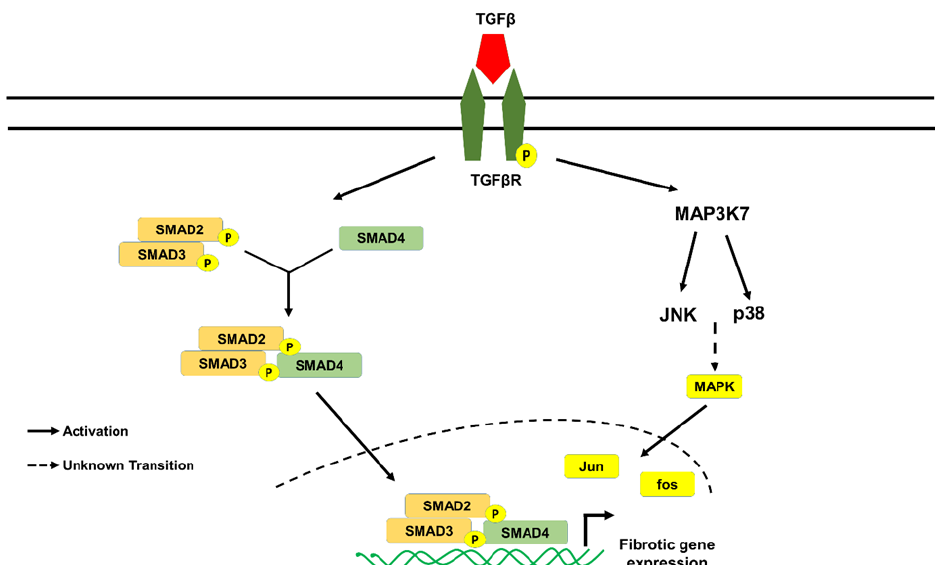
Figure 2. TGF- β signaling fibroblasts differentiation into myofibroblasts. TGF- β is the major soluble factor implicated in fibroblast differentiation. The canonical pathway includes binding of TGF- β to the TGF- β receptors resulting in the activation of SMAD2/3, which forms a complex with SMAD4, translocates to nucleus, and induces fibrotic gene expression. In contrast, non-canonical pathway includes p38 MAPK/JNK pathway, which activates Jun/Fos-dependent fibrotic gene expression. α -SMA = α -smooth muscle actin; TGF- β = transforming growth factor β ; TGF β R = transforming growth factor β receptor.